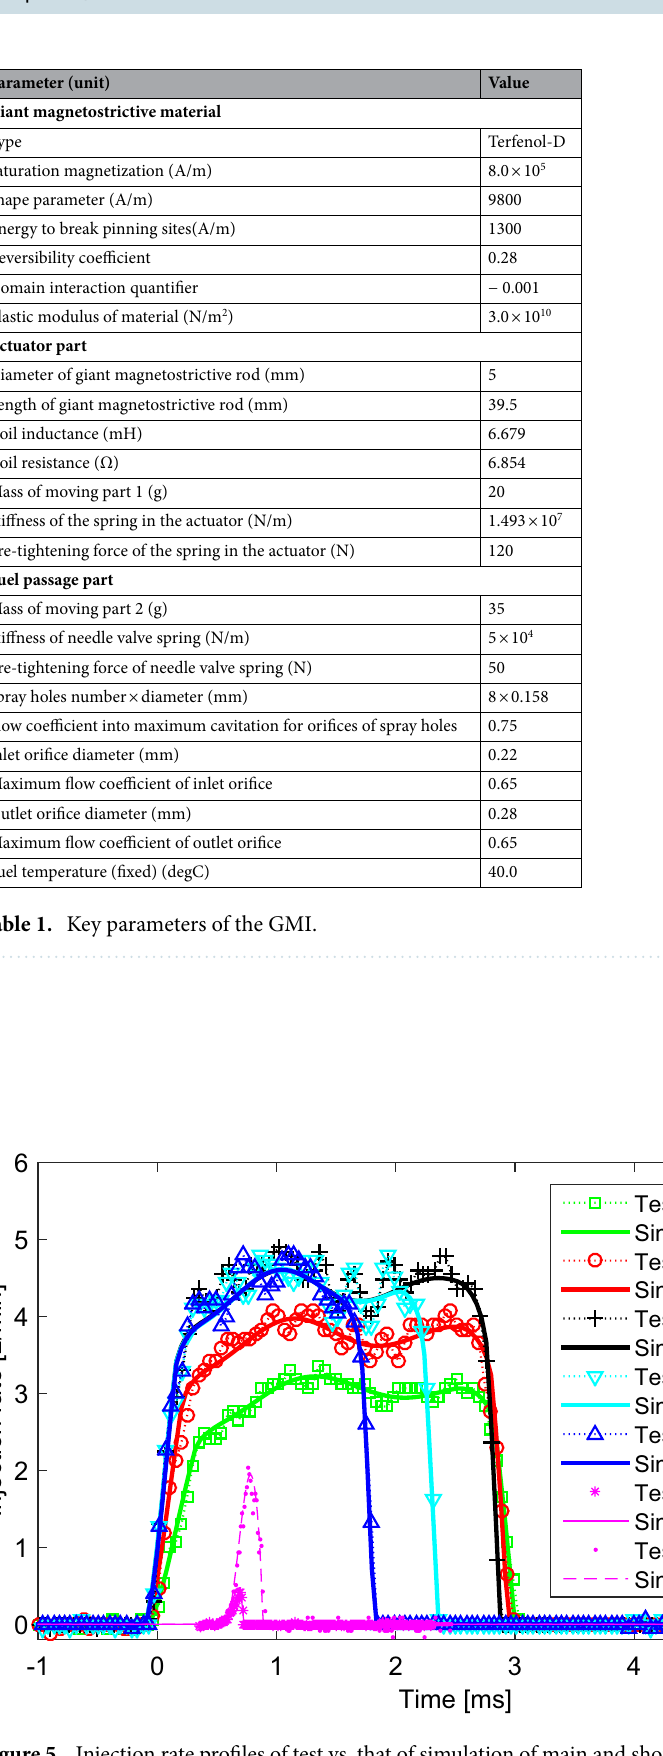
Figure 5. Injection rate profiles of test vs. that of simulation of main and short